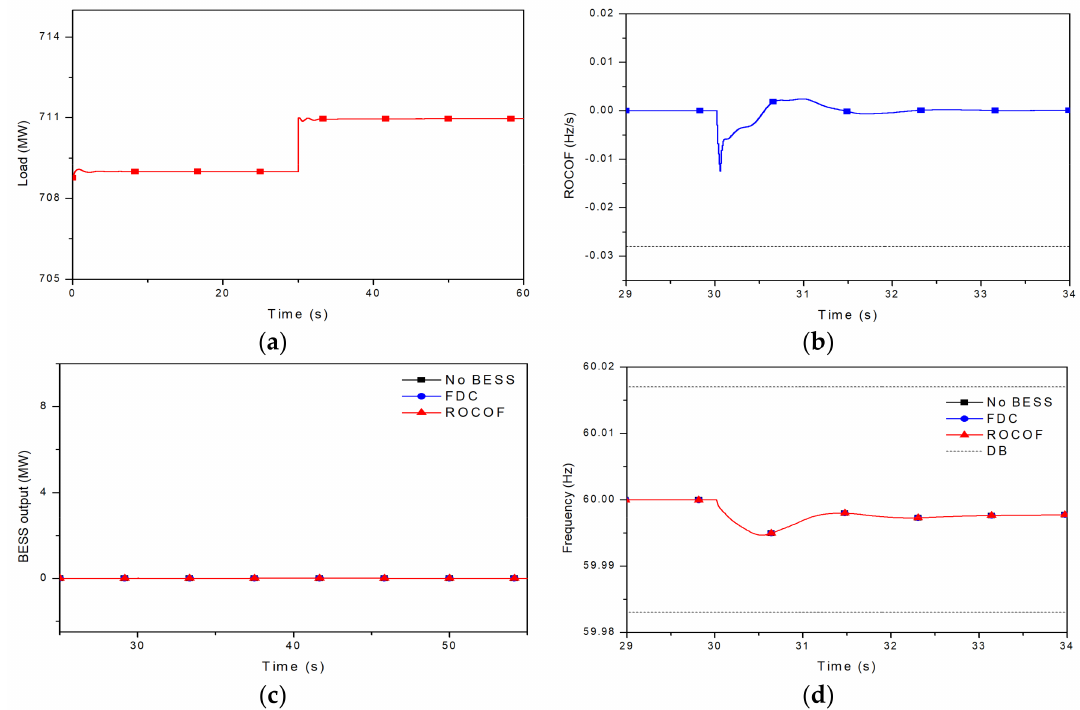
Figure 5. Power system load is increased by 2 MW: ( a ) Power system load; ( b ) Rate of Change of Frequency (ROCOF); ( c ) BESS output; ( d ) Power system